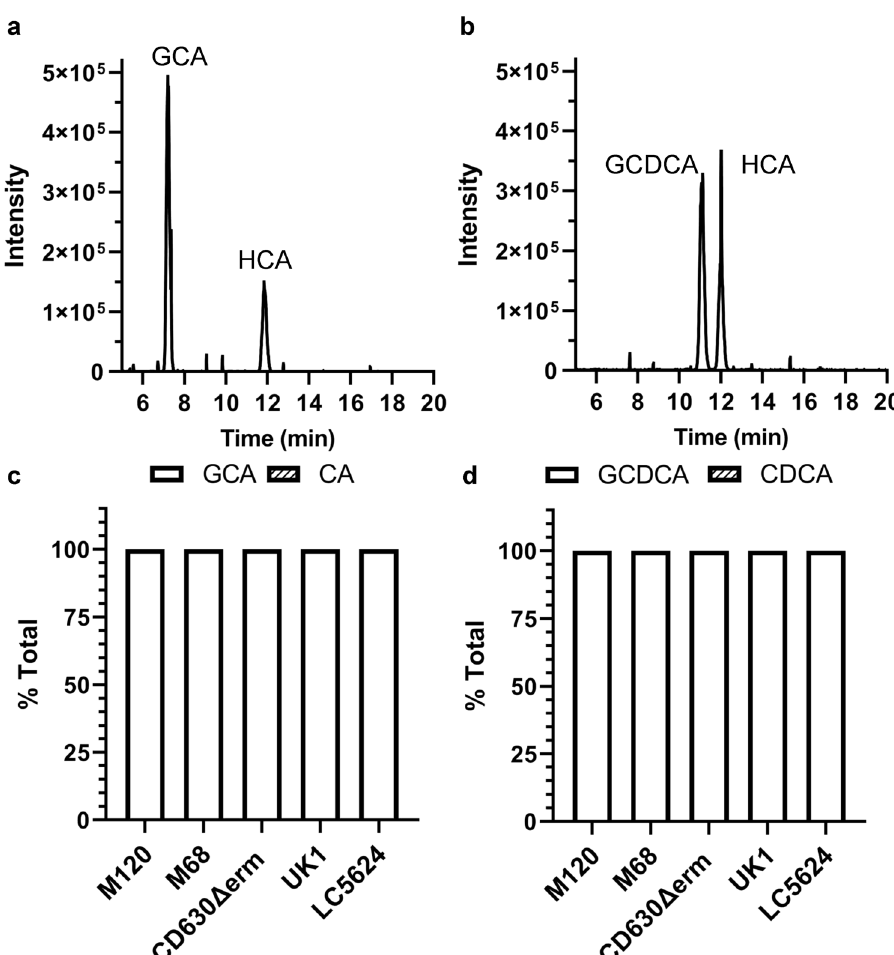
Fig. 4 C. dif fi cile BSH activity is taurine-speci fi c. C. dif fi cile CD630 Δ erm was grown in a rich medium supplemented with 1 mM glycocholate (GCA) ( a ) or glycochenodeoxycholate (GCDCA) ( b ) for 24 h. The bile salts were then analyzed for HPLC-coupled evaporative light